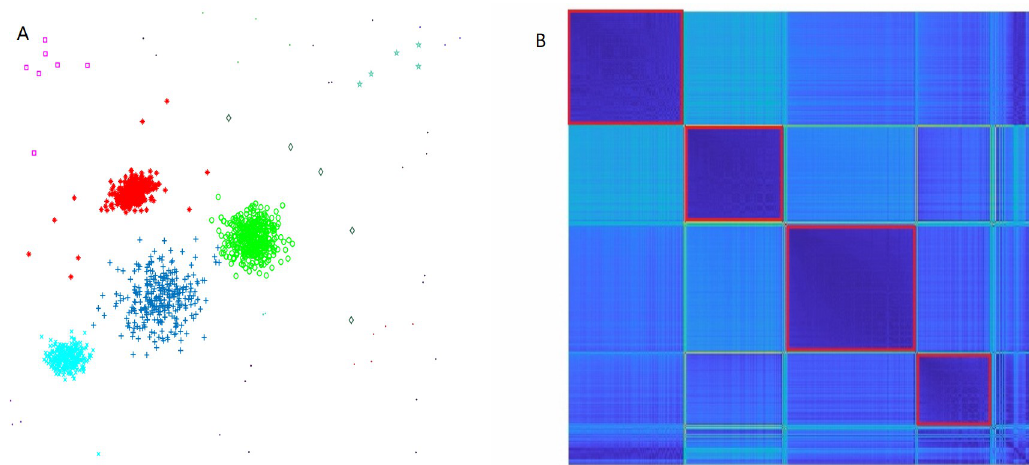
Fig 4. Heterogenous clusters with noise. (A) shows the clustering result with a scatter picture, in which the members belonging to the same clusters are shown in the same color and noise are labeled as tiny clusters; (B) shows the adjacent matrix after clustering, the blocks on the diagonal are separated